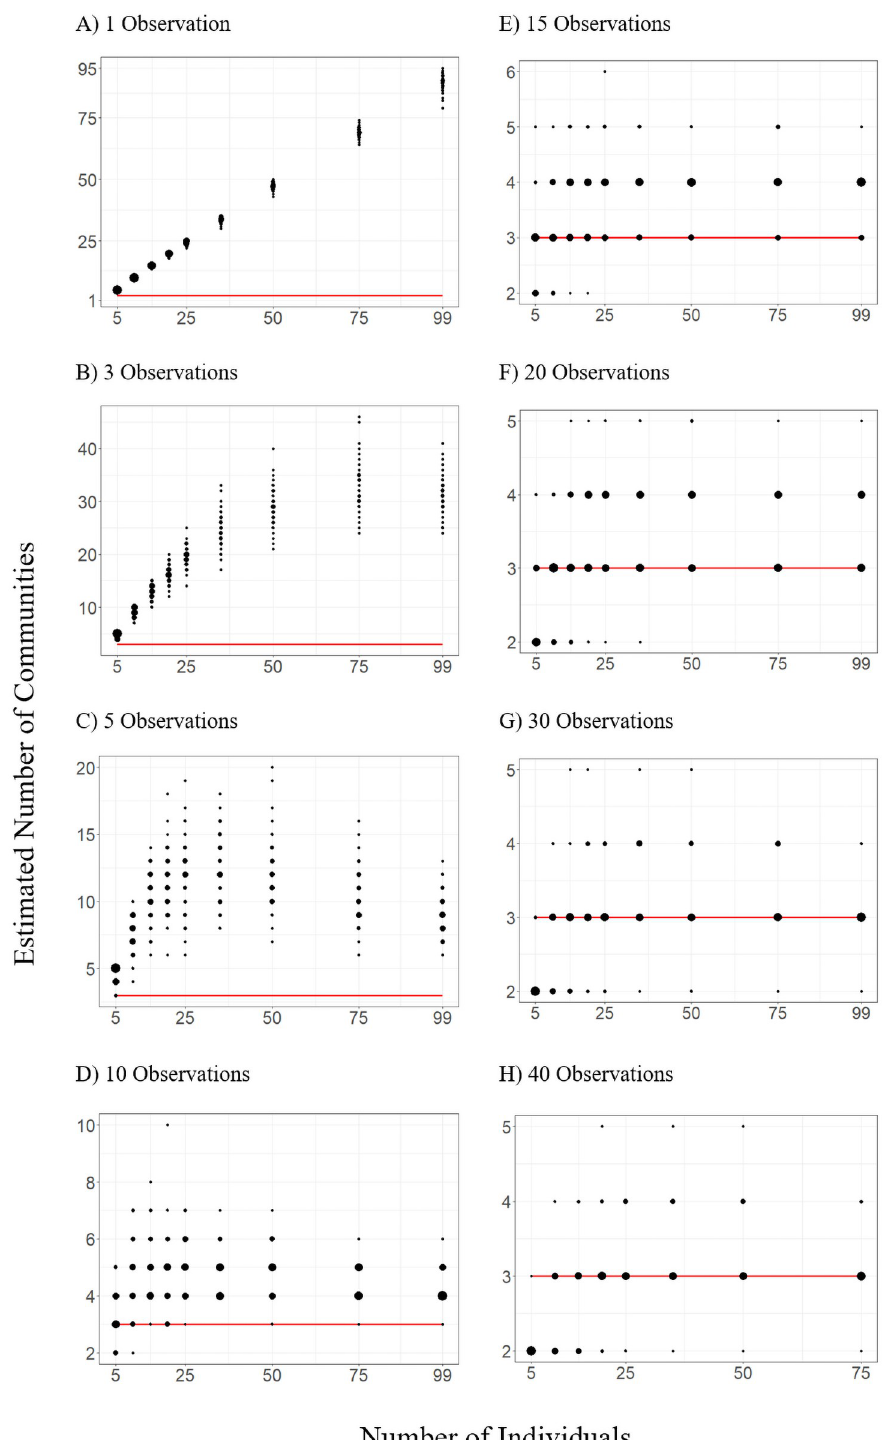
Fig 1. Variation in the estimated number of communities under various scenarios of number of individuals sampled and the number of observations per individual (panels A-H). Point sizes are scaled based on the number of times a value occurred. The red horizontal line represents the actual number of communities in the ‘observed’ population from which all other scenarios were sampled (subgroups = 3). Note, the changing y-axis scale among